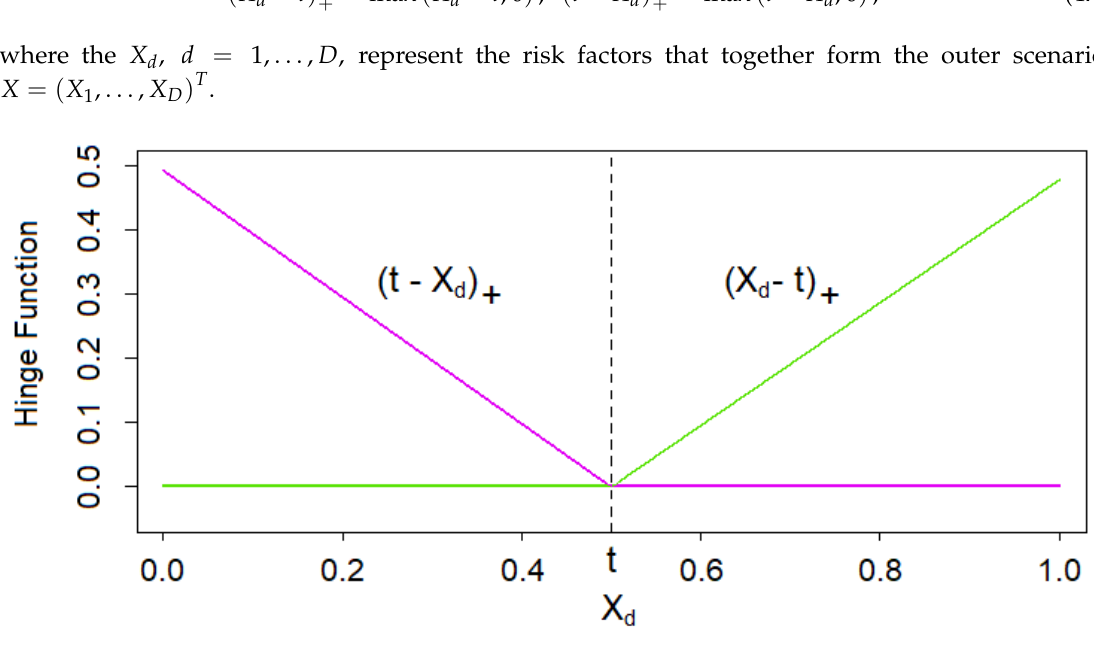
Figure 5. Reflected pair of piecewise linear functions with a knot at t